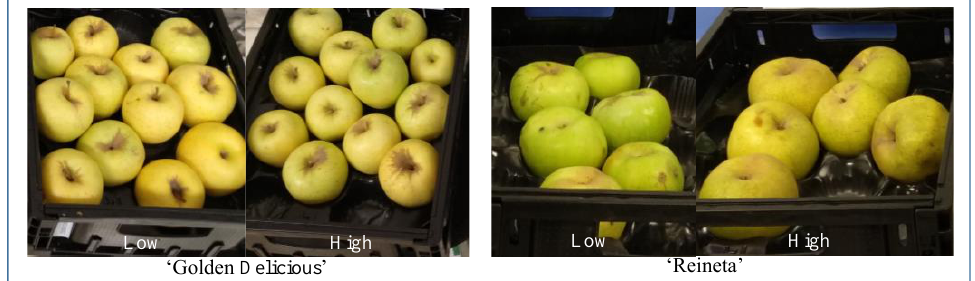
Figure 1. ‘Golden Delicious.’ and ‘Reineta’ apple cultivars grown at low and high altitudes provided Figure 1. ‘ Golden Delicious. ’ and ‘ Reineta ’ apple cultivars grown at low and high altitudes pro- to the consumers in the consumer vided to the consumers in the consumer study.